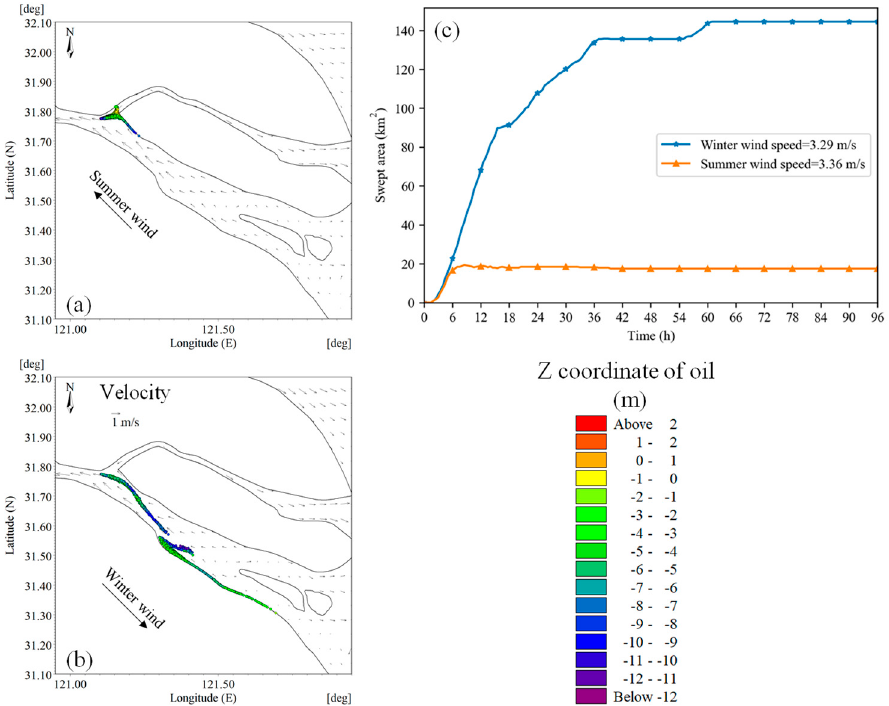
Figure 14. ( a , b ) oil particle trajectories under the influence of summer and winter monsoon, respec- tively; ( c ) swept area (km 2 ) change with two wind directions. The color of circles indicates the z coordinate of oil particles.